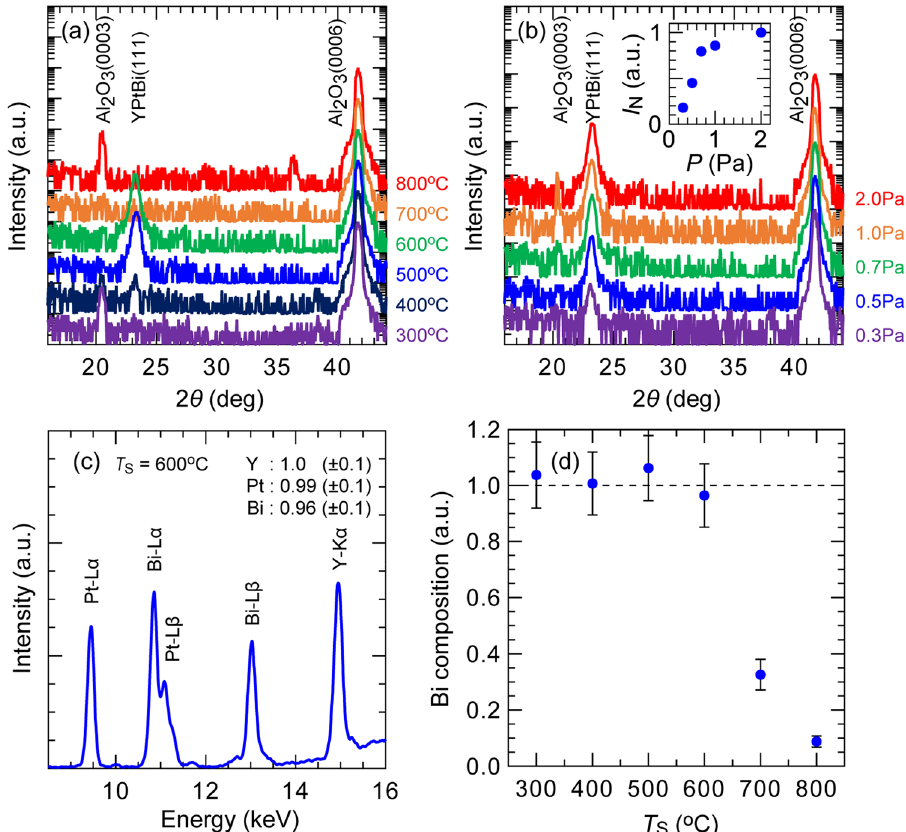
Figure 2. Crystal structure analysis of YPtBi thin films. ( a ) X-ray diffraction (XRD) θ –2 θ spectra of 50 nm-thick YPtBi films deposited on c-sapphire at different substrate temperature ranging from 300 to 800 °C and the Ar pressure of 0.2 Pa. ( b ) XRD θ –2 θ spectra of YPtBi films deposited at different Ar pressure ranging from 0.3 to 2.0 Pa at the substrate temperature of 600 °C. Inset shows the peak intensity of YPtBi(111) normalized by that at 2.0 Pa as a function of Ar pressure. ( c ) X-ray fluorescence spectroscopy (XRF) of an YPtBi thin film deposited at 600 °C. ( d ) Bi composition at different substrate temperature. YPtBi is stable up to 600